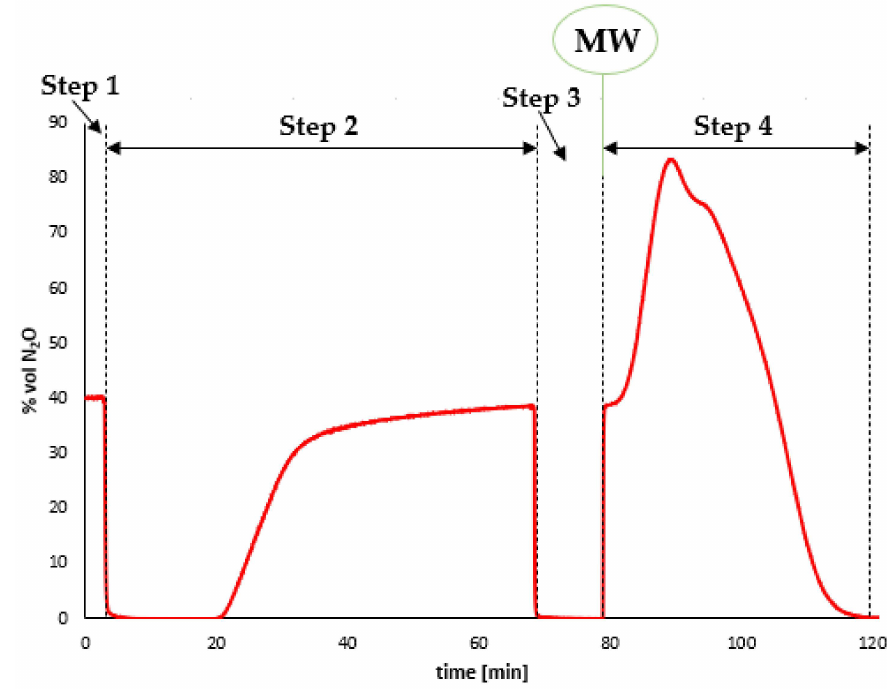
Figure 3. Complete adsorption and desorption cycle at 40% vol of N 2 O.